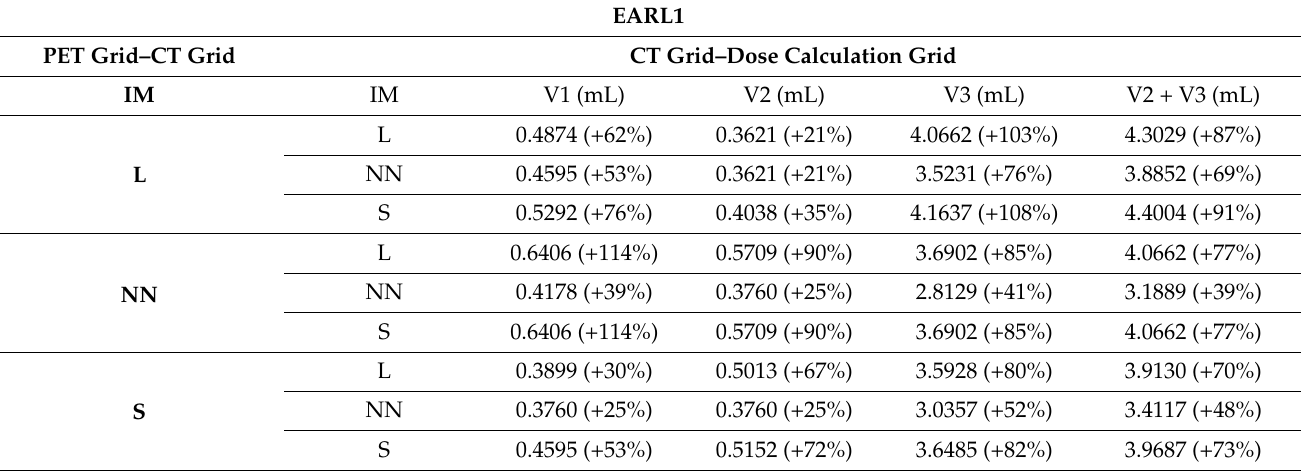
Table 1. Obtained volumes with each evaluated interpolation method for EARL1 reconstruction. The deviation from the actual volume is shown in brackets.